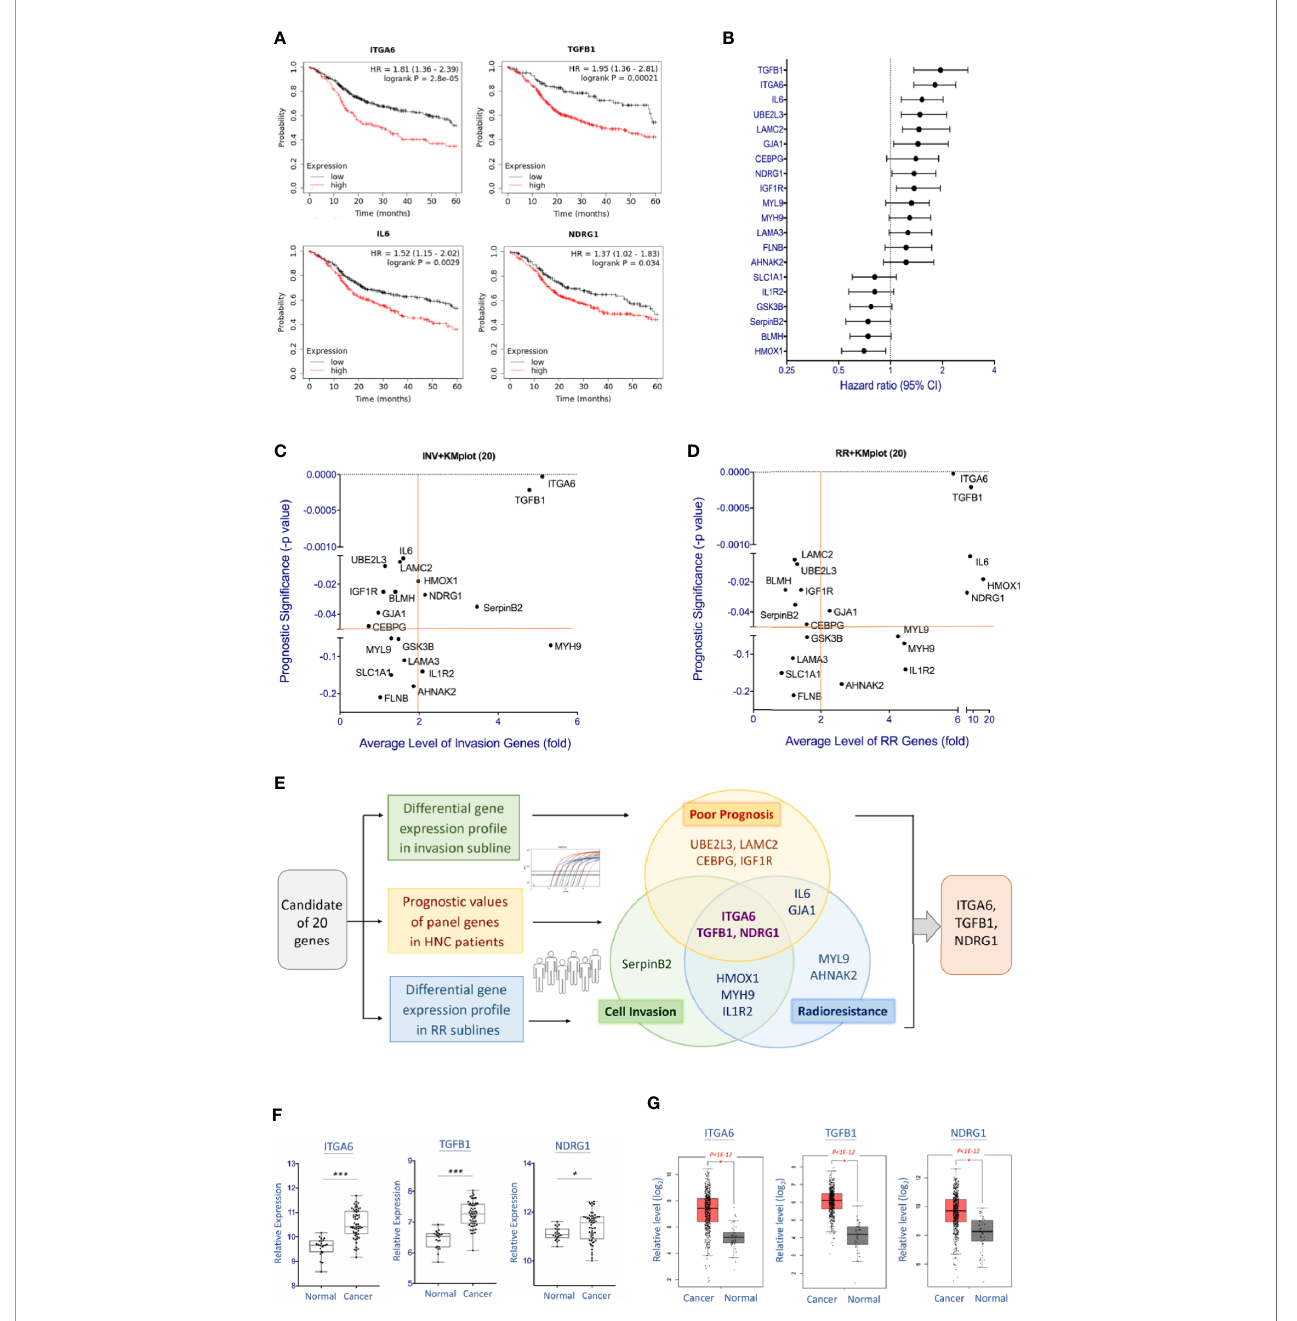
FIGURE 4 | Molecular interplays between cell invasion and radioresistance that led to poor prognosis in HNC patients. (A) Prognostic signi fi cance of represent genes in HNC patients, as determined by Kaplan-Meier Plotter online tool using the head-neck squamous cell carcinoma dataset (n = 500). (B) The overall view of the prognostic vales of 20 genes as shown by the Hazard ratio with 95% con fi dence interval (CI), as determined by Kaplan-Meier Plotter using head-neck squamous cell carcinoma dataset (n = 500). (C) The overall view of 20 gene over-expressions (x-axis) in the invasion sublines and the prognostic signi fi cance (y-axis) in HNC patients of each gene. Value further to the right are signi fi ed higher levels of over-expression, and those toward to the top represent more signi fi cance with poor prognosis. (D) The overall view of 20 gene over-expressions (x-axis) in the radioresistant sublines and the prognostic signi fi cance (y-axis) in HNC patients of each gene. Value further to the right are signi fi ed higher levels of over-expression, and those toward to the top represent more signi fi cance with poor prognosis. (E) The diagram showing the overall and overlap genes that were over-expressed in the invasion subline, in the radioresistant subline, and associated with poor prognosis in HNC patients. Note that three molecules, ITGA6, TGFB1, and NDRG1, were recruited in these three parameters. (F, G) Relative levels of the gene expressions between oral mucosa specimens from healthy individuals (Normal) and oral cancer tissues from HNC patients (Cancer). The gene expression data, including ITGA6, TGFB1, and NDRG1 was retrieved from GEO Dataset GSE25099 (F) and TCGA-HNSC dataset (G) . (***p<0.001, *p<0.05,